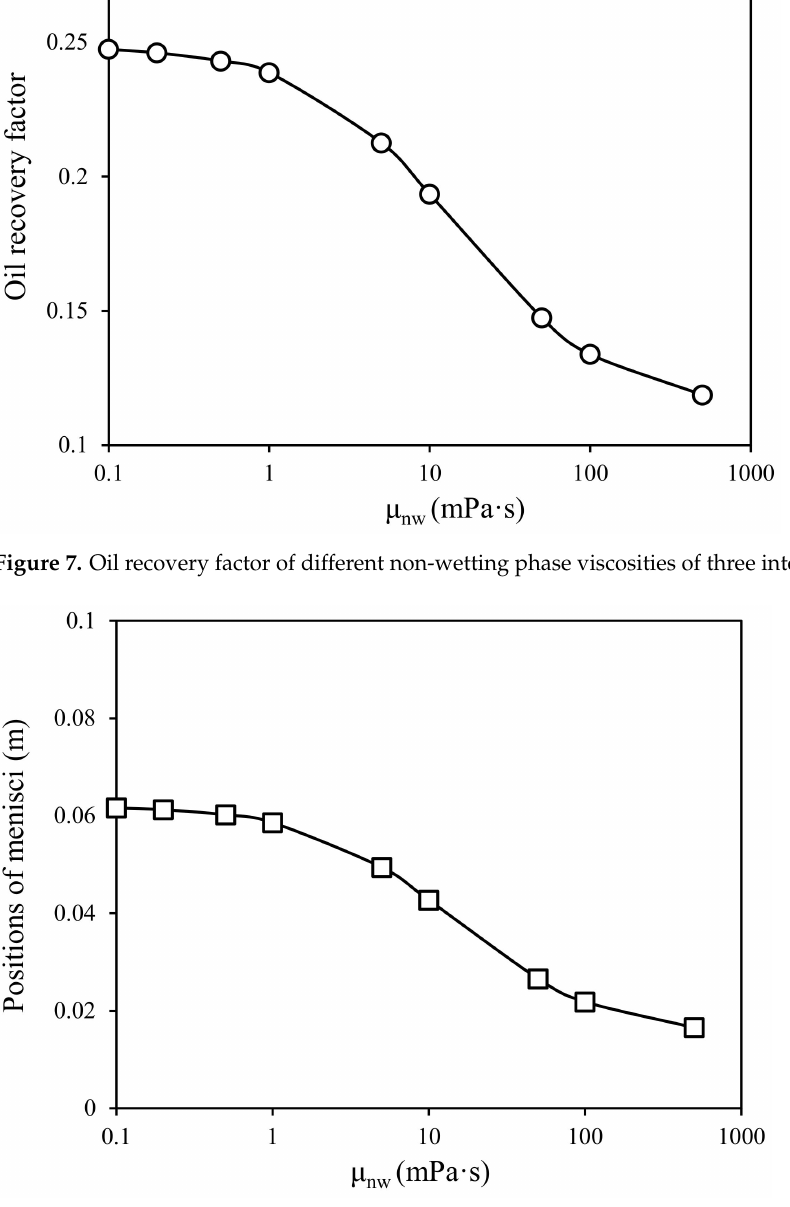
Figure 8. The positions of menisci of different non-wetting phase viscosities of three interacting capillaries. In addition, the influence of non-wetting phase viscosity is studied by changing the number of capillaries. It is found that the non-wetting phase viscosity increases, the imbibition distance of other capillaries becomes smaller, and the heterogeneity of the imbibition front becomes worse when the smallest capillary imbibes to the bottom end (Figure 9). As the viscosity of the non-wetting phase increases, the imbibition time increases. This is because the increase of non-wetting phase viscosity leads to the increase of viscous force. Therefore, the increase of imbibition resistance increases the time of